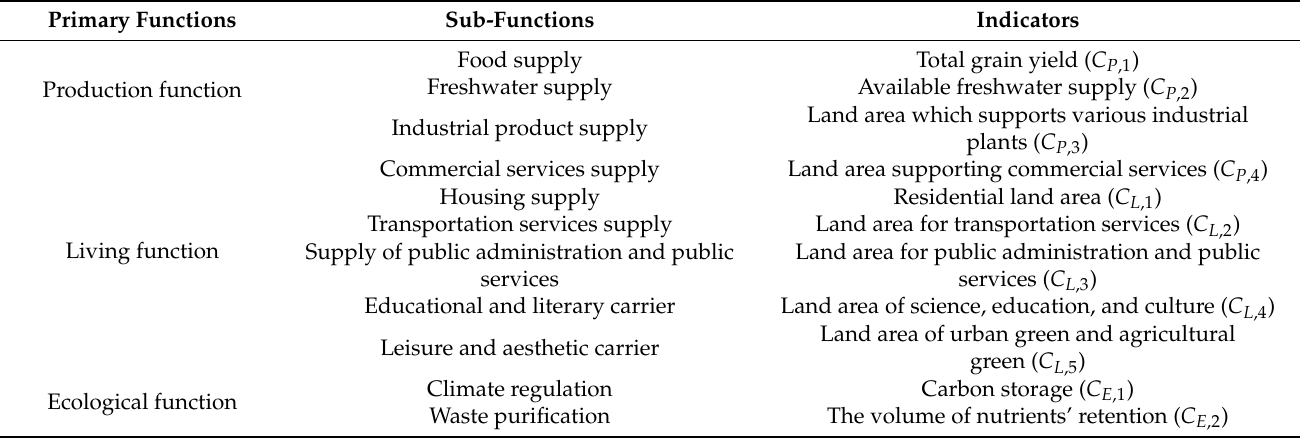
Table 4. Indicators for measuring land resources